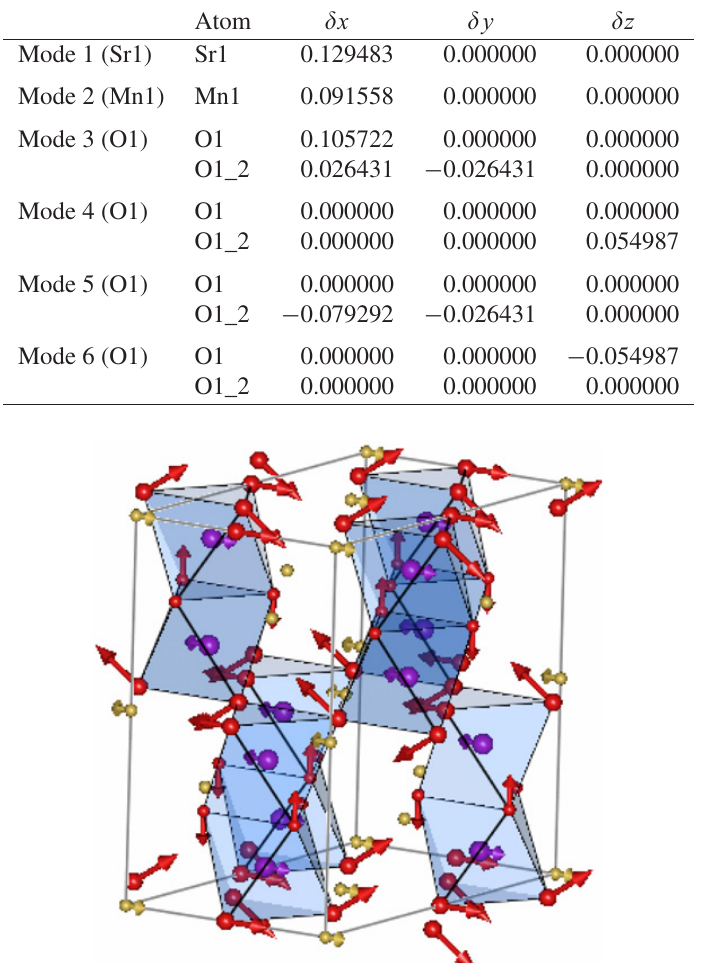
Table 9. The six basis modes corresponding to the irrep GM5 − used in AMPLIMODES to describe the GM5 − distortion present in the C 222 1 structure of SrMnO 3 . Displacements are normalized to 1Å within a C 222 1 primitive unit cell, and are described in relative units with respect to the conventional C 222 1 unit cell of the reference structure.